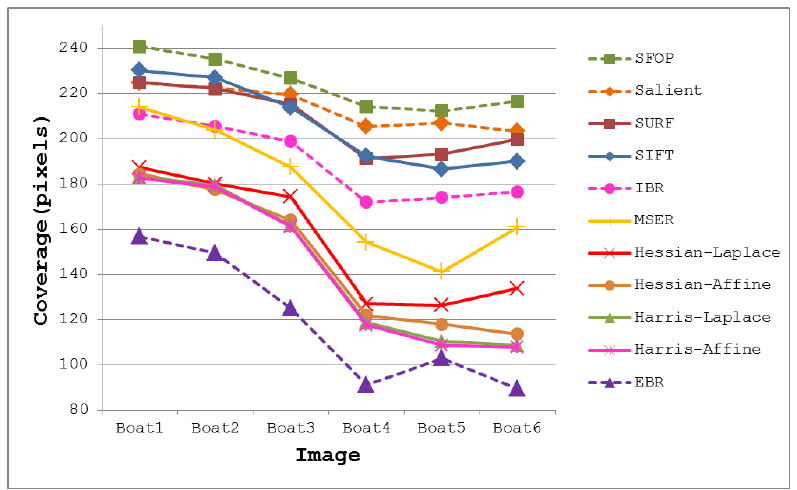
Figure 4. Coverage results for the Boat dataset [21].